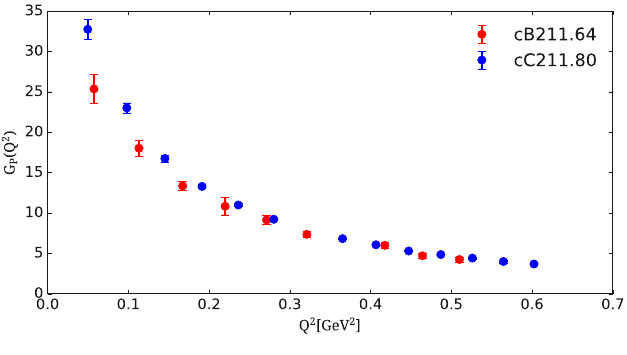
( Q 2 ) computed using the cB211.64 ensemble and an N Figure 4: G P ensemble (cC211.80) with a = 0.07 fm. Both ensembles have similar volume and m π = 0.139 GeV. Figure taken from Ref. [ 25 ] .